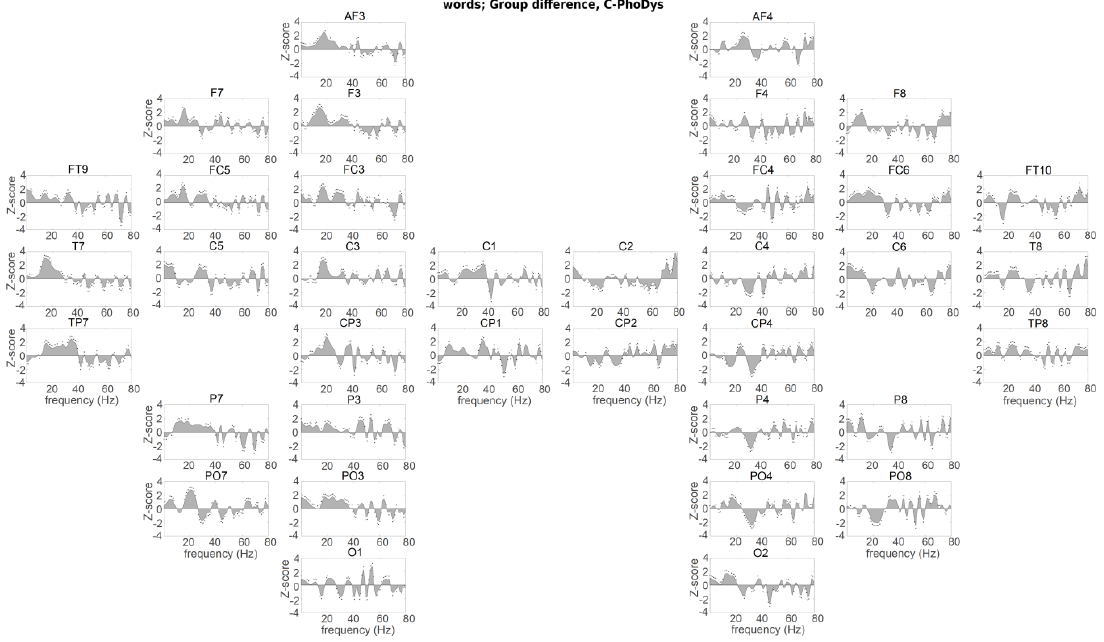
Figure 3. Hemispheric presentation of group di ff erence between controls and PhoDys for the word listening condition. Same format as Figure 2.